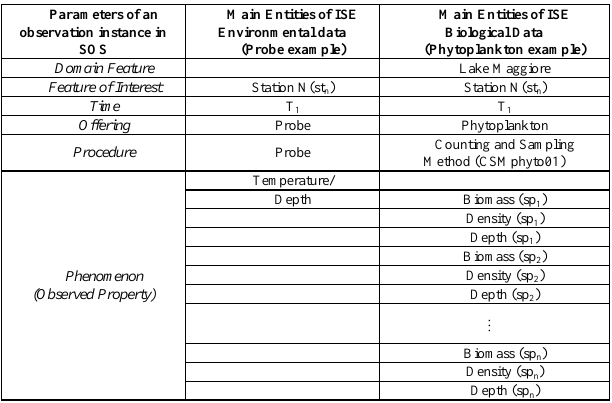
Figure 3. Option I SOS + WFS